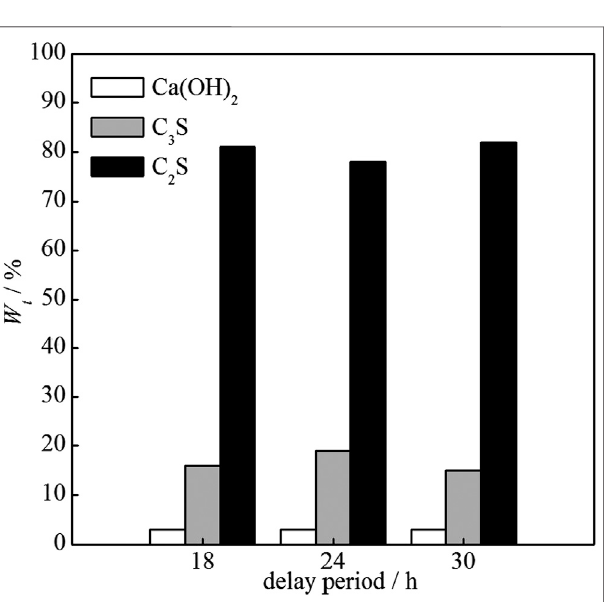
Figure 9 | Determination of content of C2S, C3S and